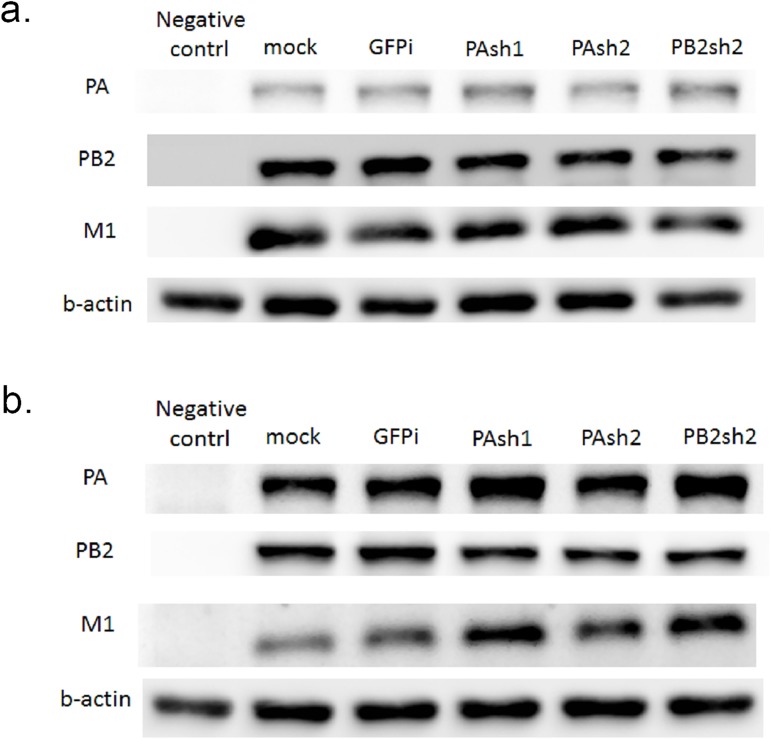
Inhibitory ability of shRNA treatment against seasonal H1N1 and H3N2 influenza virus in Vero cells.We tested treatment with 8μg of shRNA plasmid in Vero cells and co-transfected the cells with two clinical influenza isolates (seasonal H1N1 and H3N2). The results showed no obvious inhibitory effects on PA, PB2, or M protein expression in Western blot analyses.